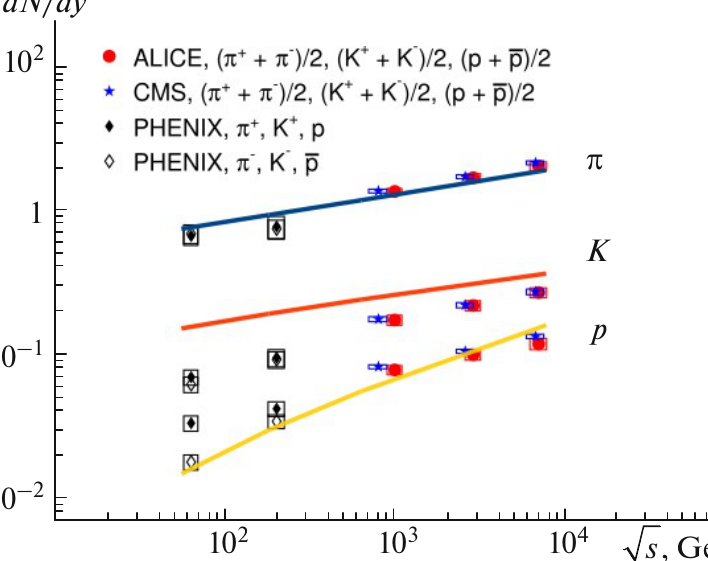
Figure 16. Energy dependence of the mean multiplicity per rapidity for charged pions, kaons and protons in pp collisions [17,18]. The lines correspond to model calculations. The points denote experimental data (see references in [111]).